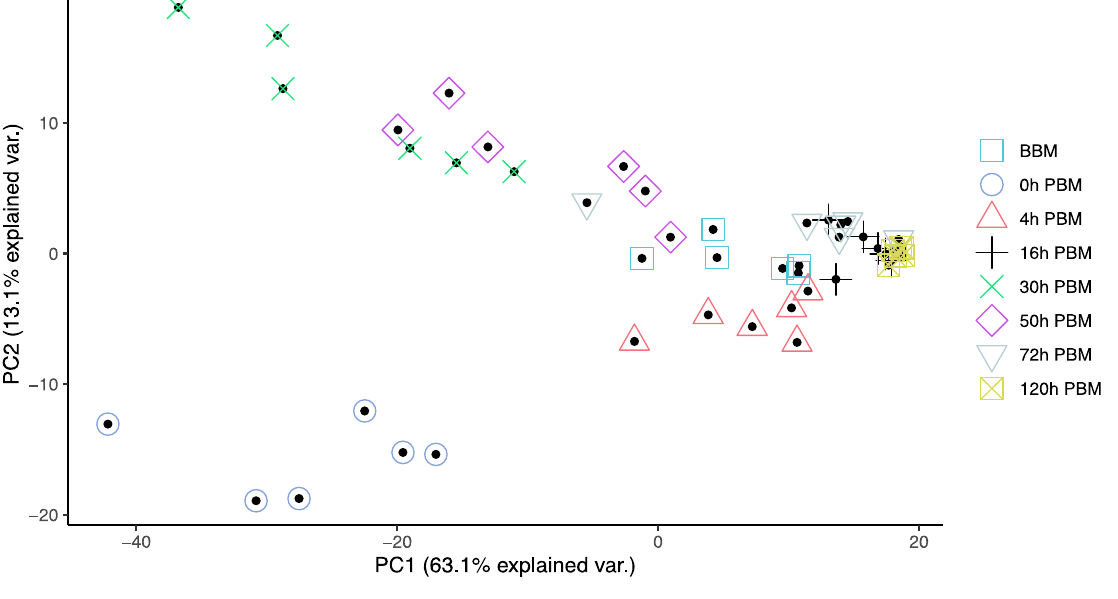
Figure 2. Principal Component Analysis suggested lipidome differences of Aedes aegypti females at different time points over the course of feeding and reproduction. Color and shape symbols correspond to the eight time points before blood meal (BBM) and post blood meal (PBM). The first two principal axes explain 76% of the variance.